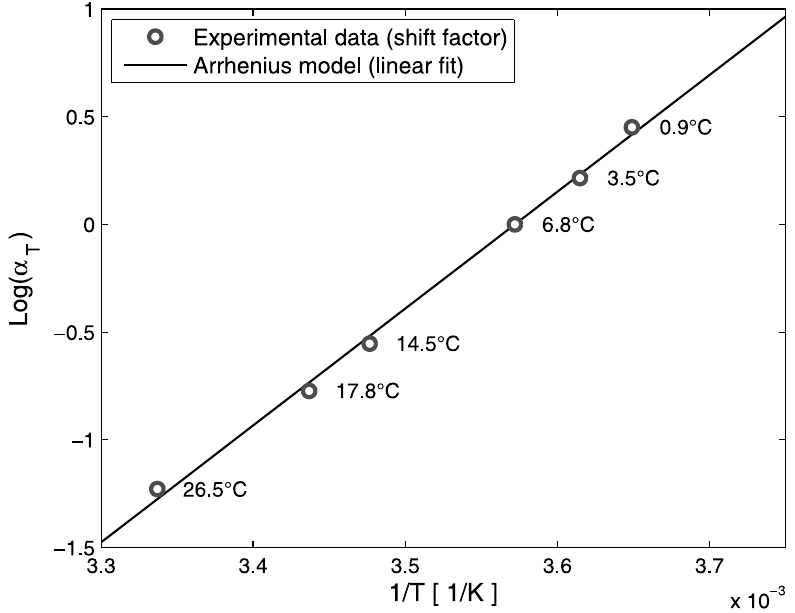
Fig. 6. Arrhenius model fitting of the shift factor values (reference temperature T 0 = 279.95 K (6.8 ◦ C), T A = 5425.6).